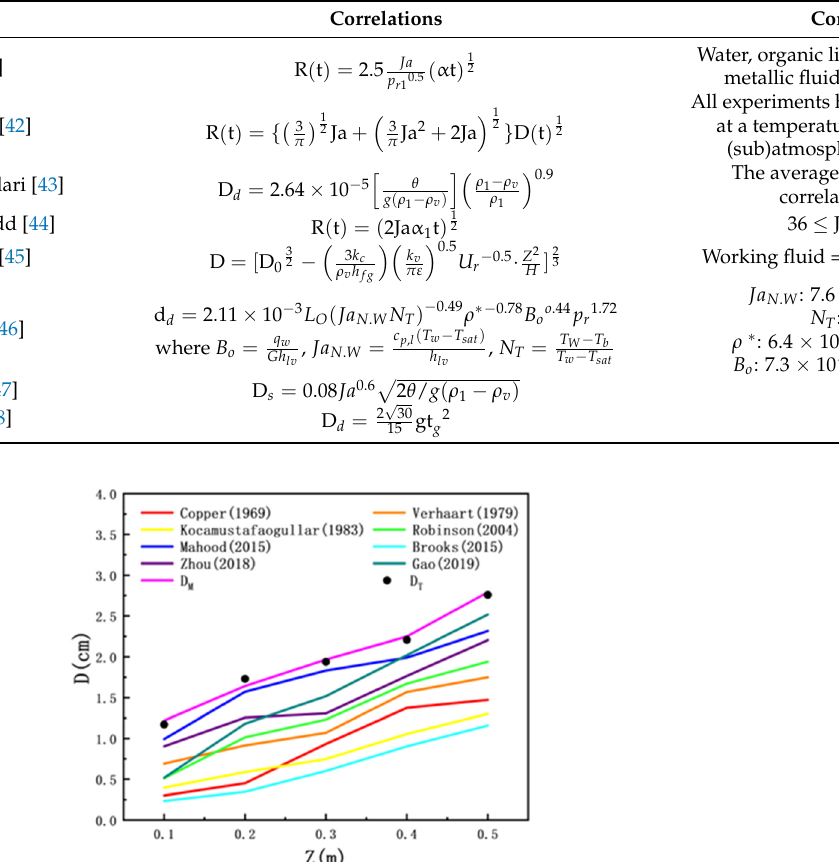
Table 4. Bubble growth equations proposed by different researchers.